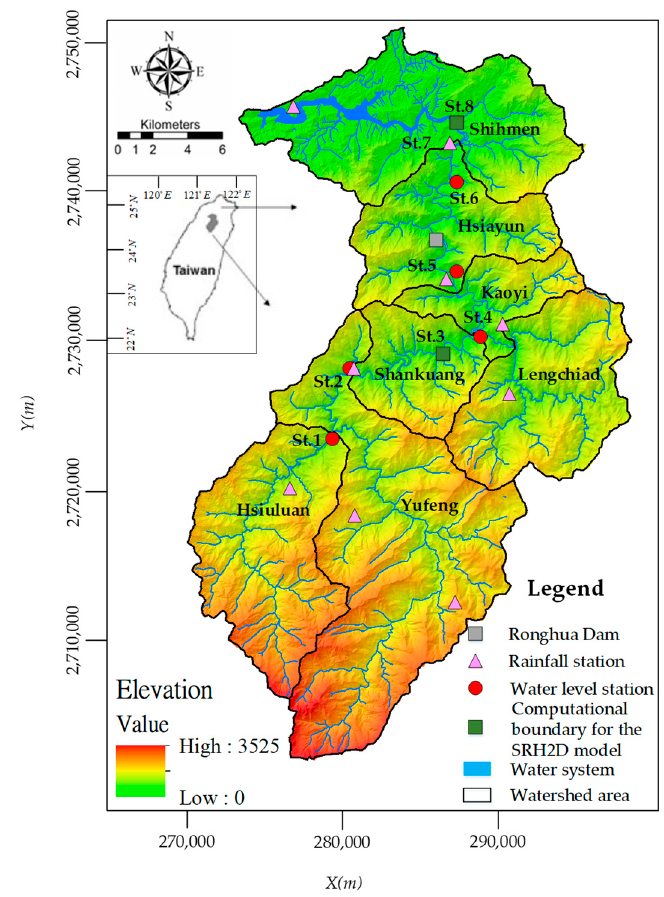
Figure 1. Sub-watersheds of the study area—Shihmen reservoir watershed, Taiwan. X(m) and Y(m) are based upon the TWD97/TM2 coordinate system. The inset figure shows the longitude and latitude of the study areas.